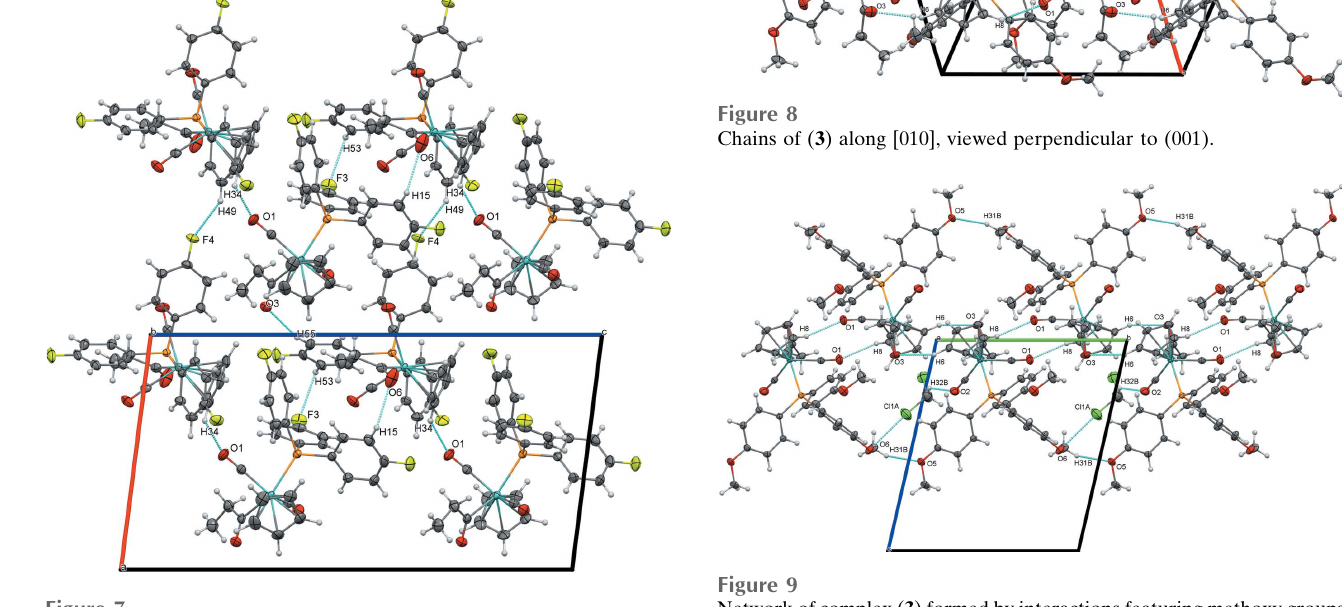
Figure 7 Sheets of ( 2 ) parallel to (010), viewed perpendicular to (010). 4 of 7 Whited et al. (cid:3) cyclopentadienylmolybdenum(II) propionyl complexes Acta Cryst. (2021). E 77